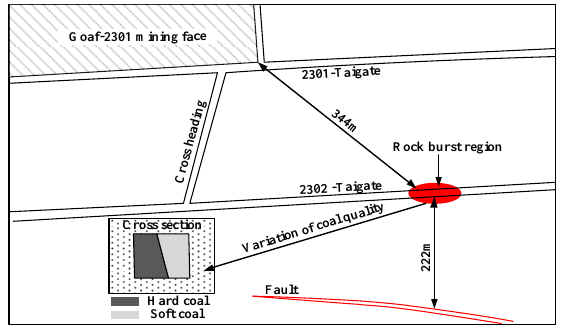
Figure 8. Rock burst region in the No. 1 mining face [26].